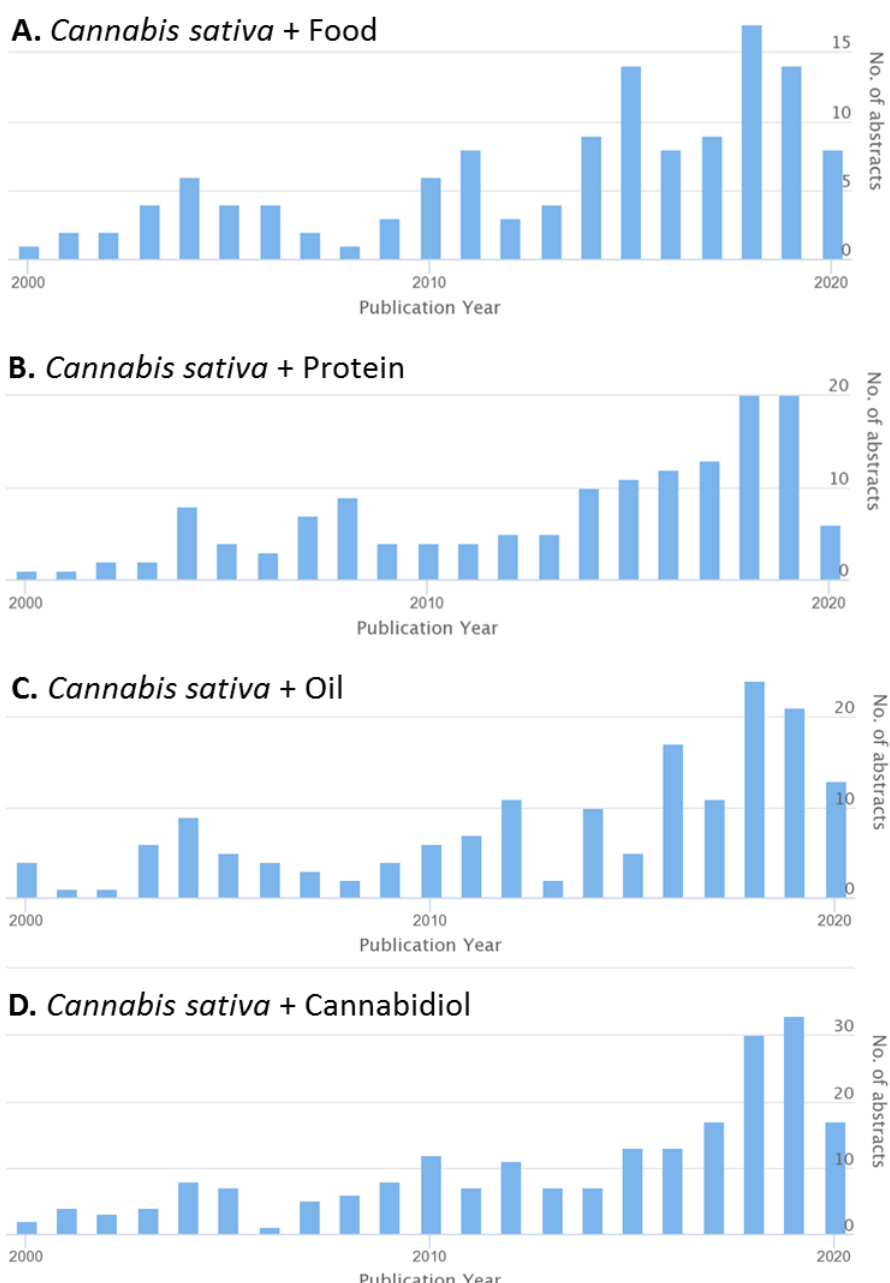
Figure 1. Number of abstracts in the CAB international database in the last 20 years. The search with the keywords ( A ) Cannabis sativa + Food, ( B ) Cannabis sativa + Protein, ( C ) Cannabis sativa + Oil, ( D ) Cannabis sativa +